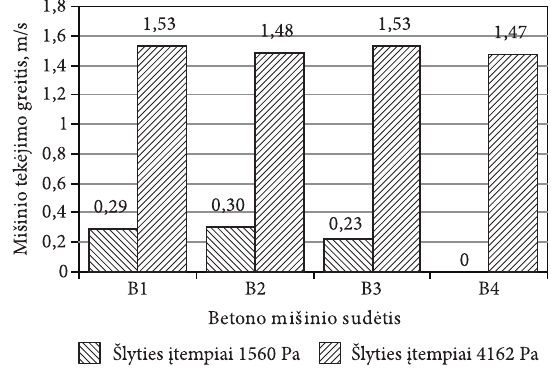
Fig. 4. The dependence between concrete mixture flow characteristics and concrete mixture‘s